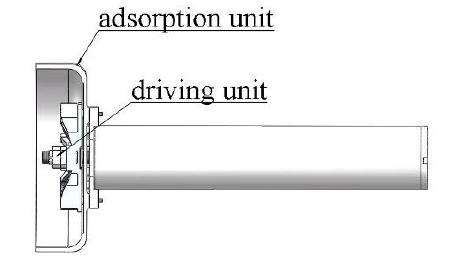
Figure 1. Sectional view of absorber.